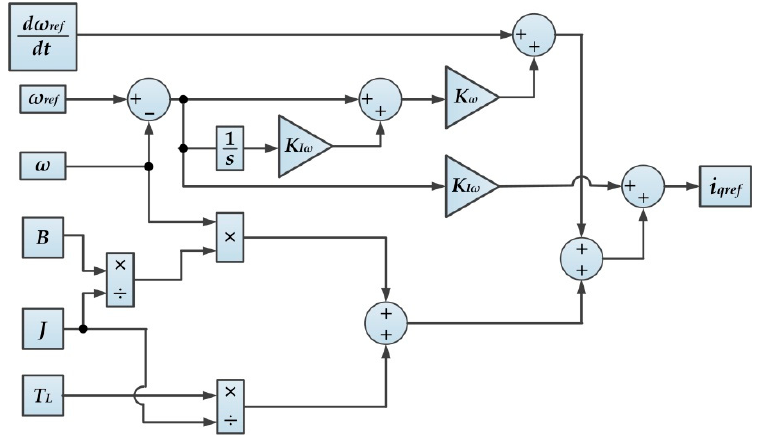
Figure 6. Block diagram of the synthesized control signal i qref .